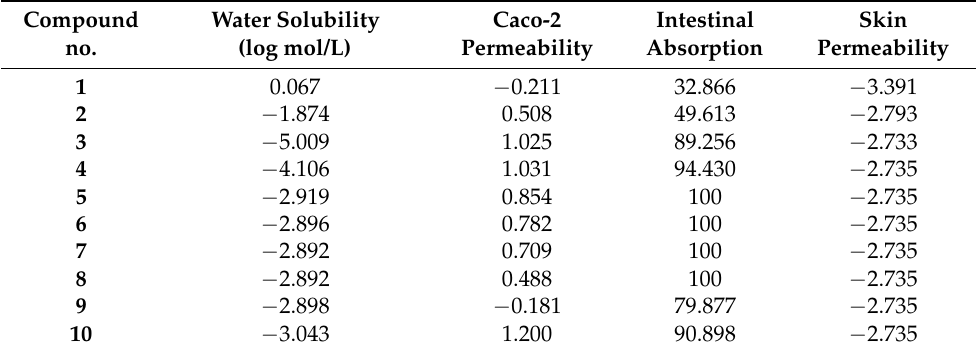
Table 6. Prediction of in silico absorption of MGP analogs.